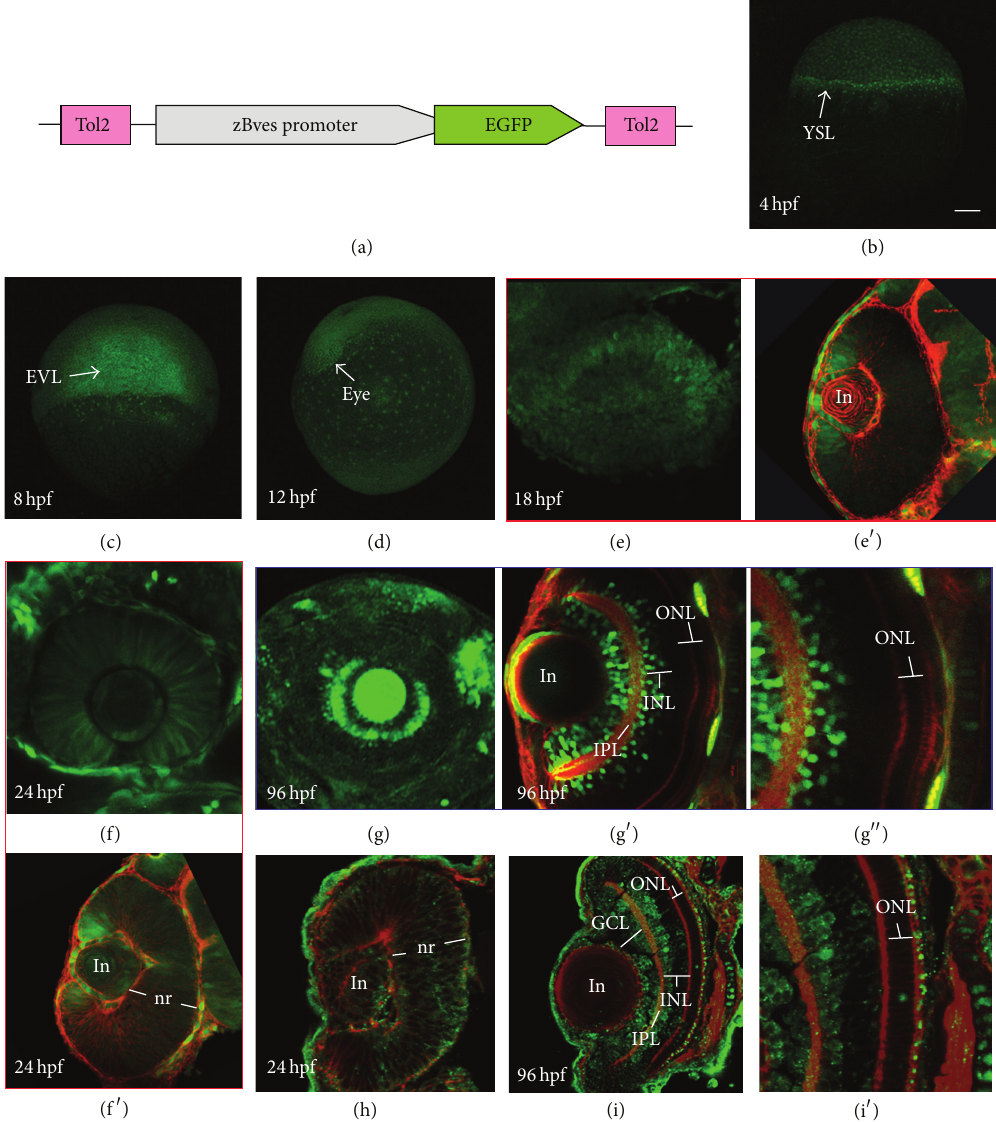
Figure1:ZBvesexpressionintheeyesoftransgenicline.TheTol2transposonsystemwasestablishedtoproduceaTg( zbves : EGFP )transgenic zebrafish line. The zbves promoter sequences were cloned in the Tol2-containing vector (a). The F3 transgenic embryos were observed